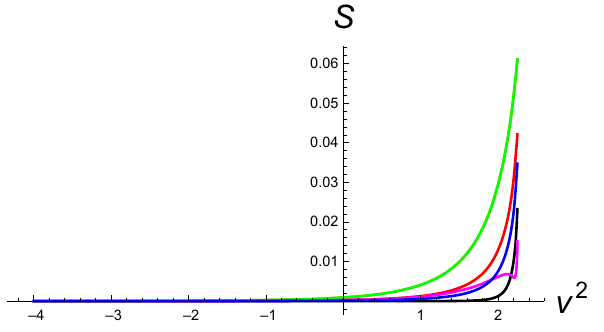
Fig. 2 Entanglement entropy versus ν 2 = 9 / 4 − m 2 / H 2 plots for various values of the parametrisation θ RL . The green curve corresponds to θ RL = 0 , π/ 2,theredto θ RL = π/ 6,theblueto θ RL = π/ 5,theblack to θ RL = π/ 4 and the pink to θ RL = π/ 3. We may chiefly note that a the θ RL = 0 , π/ 2 plots are exactly coincident and they give maximum entanglement entropy for all values of ν 2 b the pink curve ( θ RL = π/ 3) has extrema, whereas the other plots are monotonic. c For any given value of θ RL , the entanglement entropy has its maximum value in the massless limit, ν 2 = 9 / 4